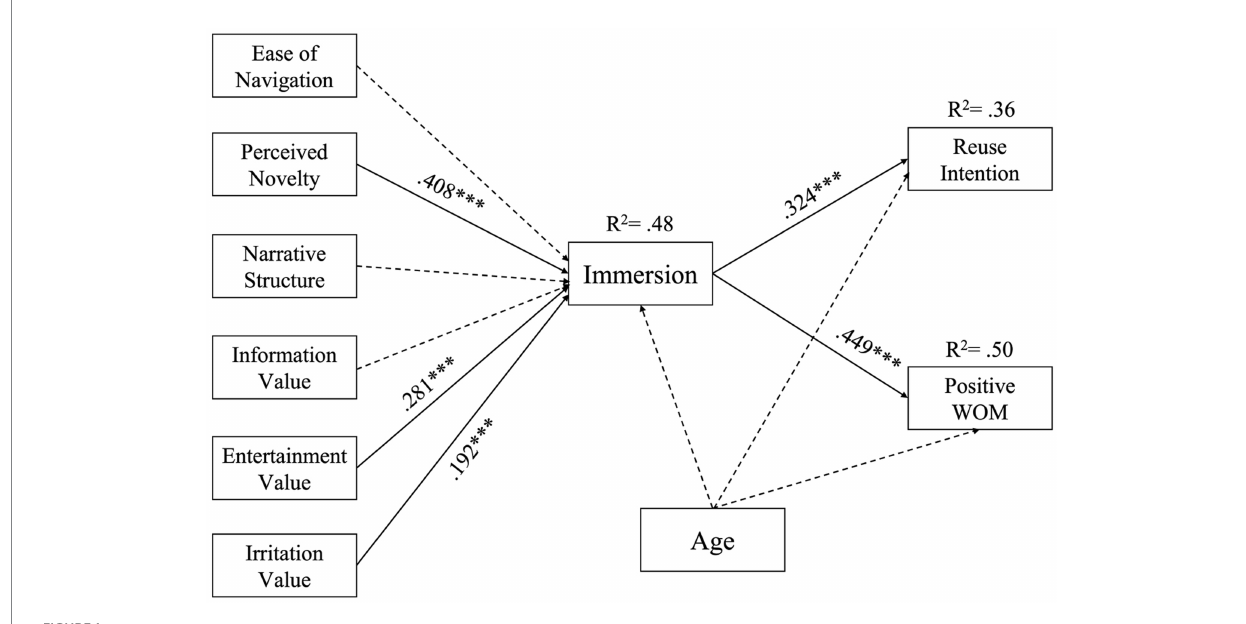
FIGURE 1 Structural model.